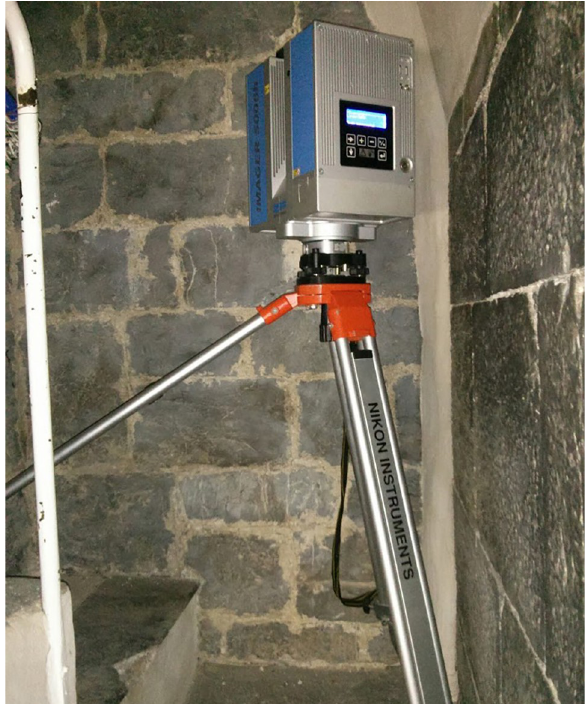
Figure 3. Image of laser scanner station inside the bell tower